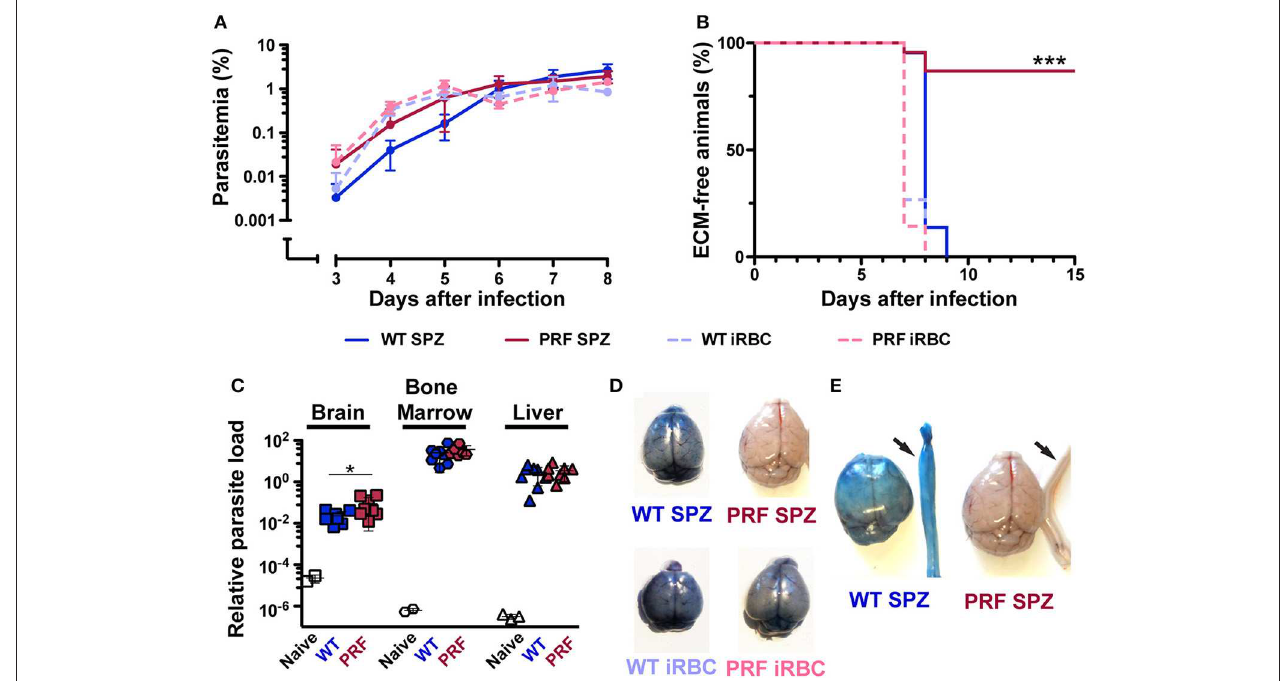
FIGURE 2 | Full virulence after PRF blood infection, but very low ECM pathology after sporozoite infection. (A) Time course of blood infection after sporozoite inoculation or transfusion of iRBCs. C57BL/6 mice were infected by intravenous injection of 5,000 hemocoel sporozoites (solid lines) of either wild type (WT; blue) or PRF (red) parasites ( n = 22 each) or 5,000 iRBCs (dashed lines) of WT (blue) or PRF (red) parasites ( n = 15 each). Parasitemia was monitored daily by microscopic examination of Giemsa stained blood-films. Differences between asexual blood-stage propagation were non-significant (Mantel-Cox test). (B) Kaplan-Meier analysis of time to development of signature symptoms of experimental cerebral malaria (ECM). *** P < 0.001 (Mantel-Cox test). (C) Quantification of parasite loads in the brain (square), BM (polygon) and liver (triangle) was done by qPCR. Organs were harvested 6 days after infection of C57BL/6 mice with 5,000 WT or PRF sporozoites. Animals were perfused via the left heart ventricle to remove non-sequestering infected red blood cells from the circulation of blood. Relative expression levels of P. berghei 18S rRNA were normalized to mouse GAPDH . Results represent mean values ( ± SD). * P < 0.05 (Mann-Whitney test). (D) Visualization of integrity of blood-brain barrier in infected mice. Infected mice were intravenously injected with 2% Evans blue dye 8 days after infection by 5,000 WT sporozoites (upper left), PRF sporozoites (upper right), WT- iRBCs (bottom left), and PRF-iRBCs (bottom right). (E) Vascular leakage also occurs in the spinal cords of mice with ECM symptoms. Isolated spinal cords are indicated by arrows and show leakage of the dye in mice with signature ECM symptoms.